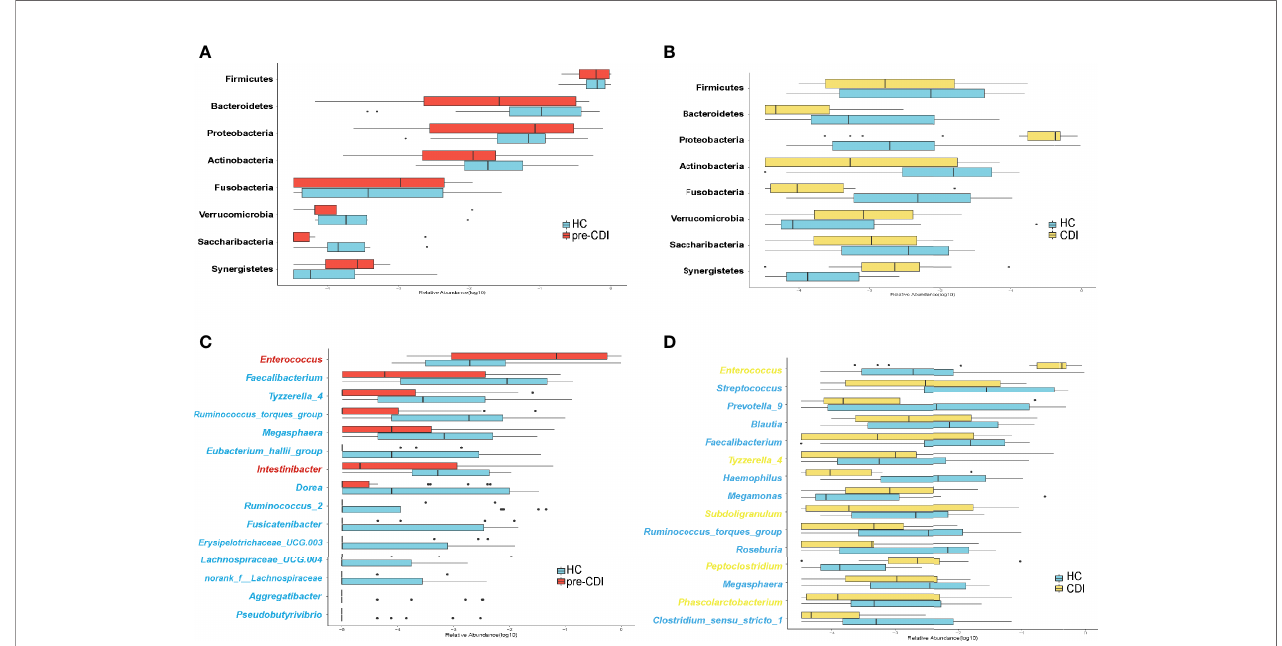
FIGURE 3 | Microbiome alterations at the phylum and genus levels among the three groups. (A) The relative abundance of eight phyla between the pre-CDI (n=22) and HC samples (n=21). (B) The relative abundance of eight phyla between CDIs (n=22) and HC samples (n=21). (C) The relative abundance of 15 genera between the pre- CDI and HC samples. (D) The relative abundance of 15 genera between the CDI and HC subjects. The relative abundances of the phyla and genera are drawn on a log scale. Taxa enriched in HC patients are in blue text, and taxa overrepresented in pre-CDI and CDI samples are in red and yellow text,